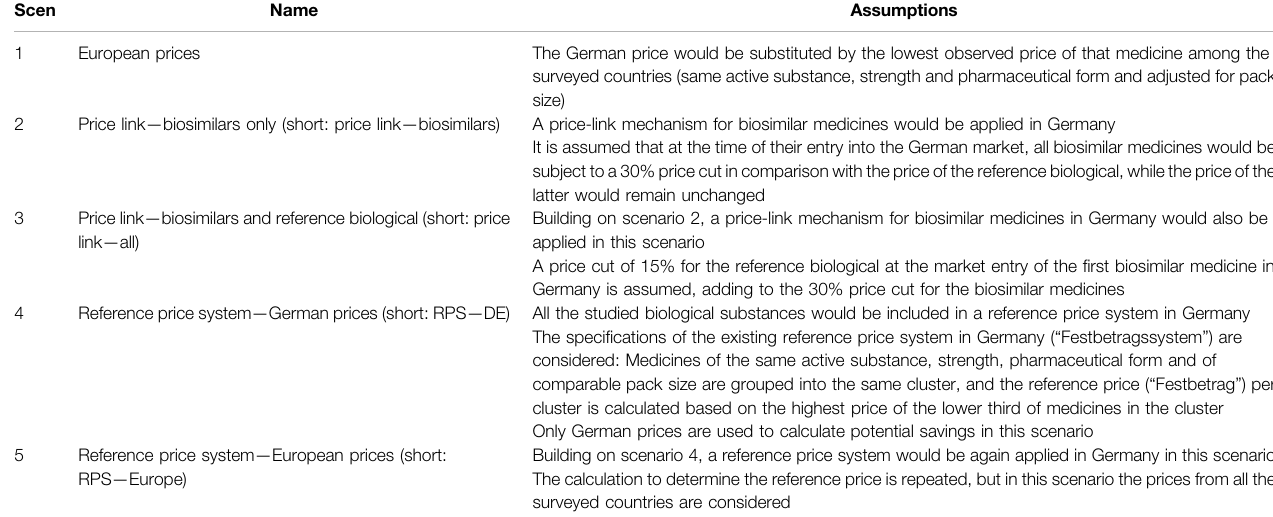
TABLE 1 | Selected scenarios and